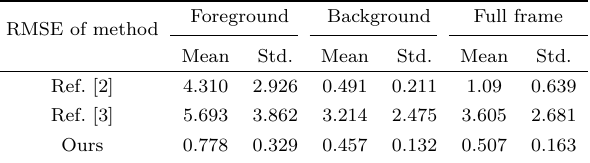
Table 1 A quantitative evaluation of the transition quality. Here RMSE is the root-mean-square error of feature positions within a single frame pair. Within each transition sequence, based on all the frame pairs, we collect two statistics: mean and standard deviation (“Std.”) of RMSE. Since there are multiple videos, we then report the mean of these statistics across all videos RMSE of method